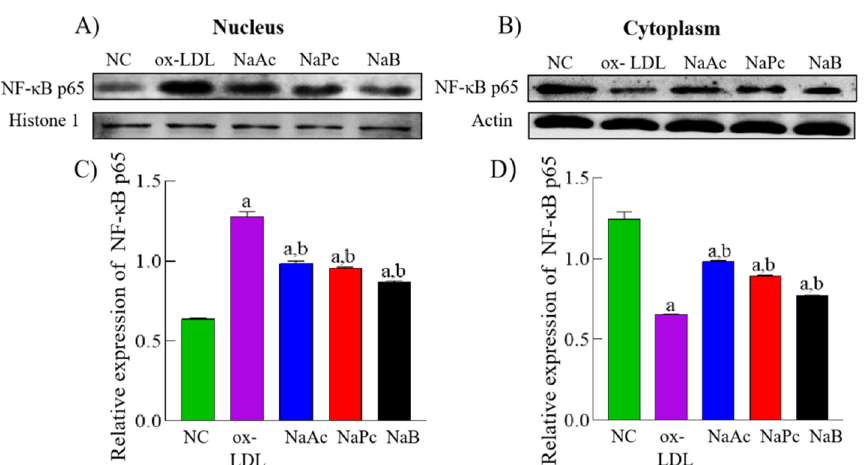
Figure 2. NF- κ B p65 expressions in THP-1 cell nucleus and cytoplasm. The THP-1 cells were pre- treated with 50 mg/L ox-LDL for 24 h and then treated with 200 µ mol/L NaAc, NaPc, and NaB for 24 h. The expressions of NF- κ B p65 were determined by Western blotting assay. ( A , C ) are in the nucleus; ( B , D ) are in the cytoplasm. a p < 0.05 vs. NC group. b p < 0.05 vs. ox-LDL